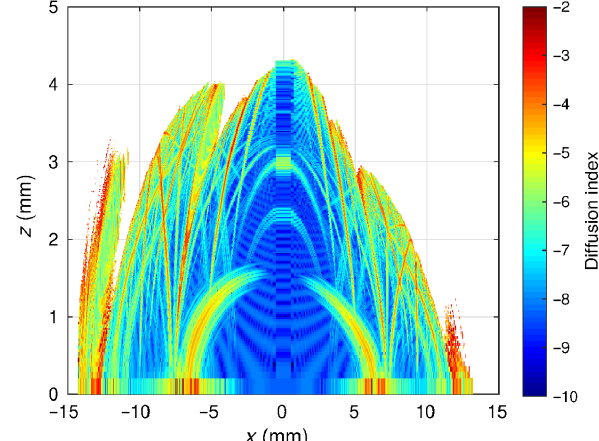
FIG. 2. Dynamic aperture of the bare lattice, including the permanent magnet – based 2.8 T superbend magnet (presented in Sec.II B). All the scrapers are fully extracted and the septum blade is inserted to − 19 . 5 mm. The color code refers to the diffusion index of the tune for 1000 turns using frequency map analysis [16].